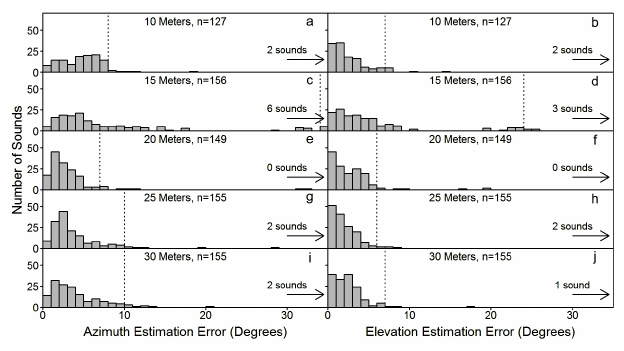
Fig. 2 . Error distributions for direction-of-arrival (DOA) estimation carried out at five distances from the microphone system. Each azimuth and elevation distribution represents a combination of errors from trials at two locations (45° and 285° in azimuth relative to the microphone system). Gray bars indicate counts of azimuth (a, c, e, g, and i) and elevation errors (b, d, f, h, and j) relative to the true DOA. Dotted vertical lines indicate the accuracy threshold below which 95% of errors occurred. Numbers at the lower right of each plot indicate the number of sounds with errors greater than 35°, and total sample sizes are indicated in each plot window. Sample sizes include sounds from all four